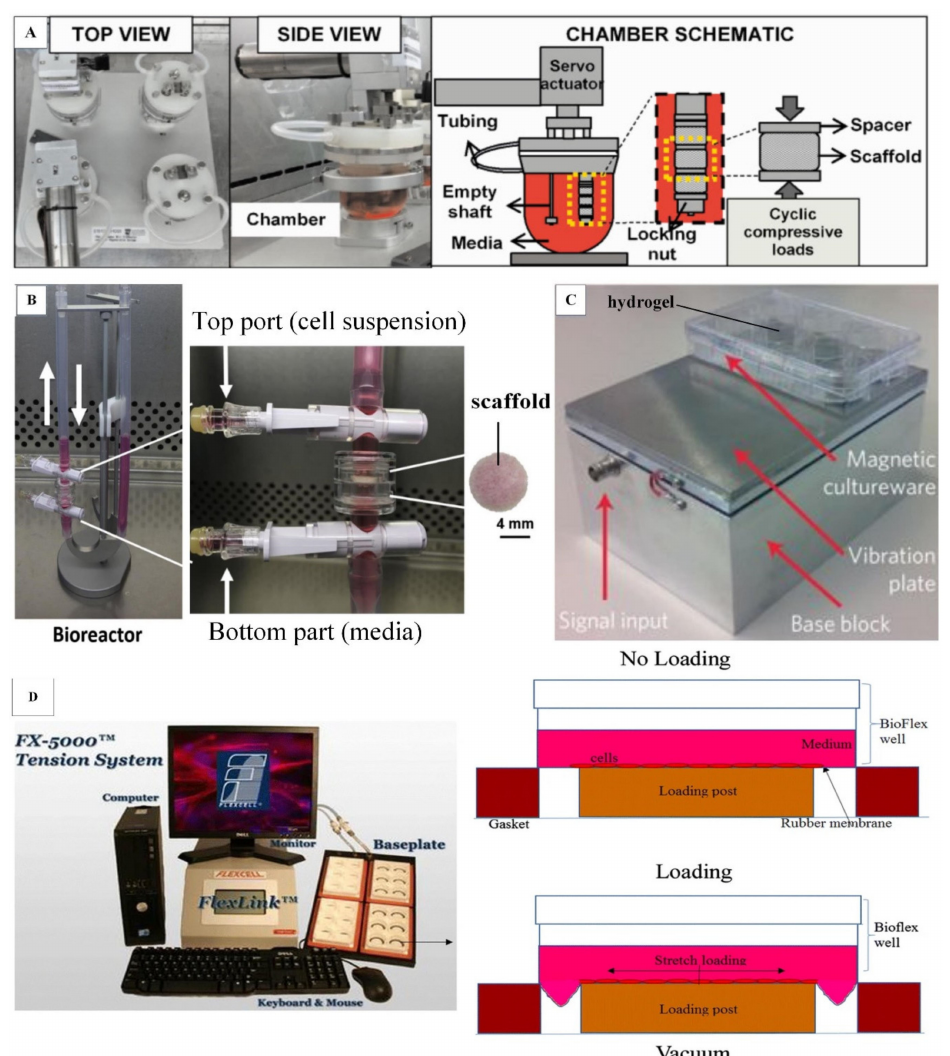
Figure 1. Bioreactors for bone tissue engineering. ( A ) Compression bioreactor. The locking nut tightens the sca ff olds to the shaft of the chamber lid and support the sca ff olds from the bottom. During loading, the locking nut and a micromanipulator on the top of the chamber compress the sca ff olds simultaneously. Adapted with permission from [26] © John Wiley & Sons (2017). ( B ) Oscillatory perfusion bioreactor. Perfusion rate is controlled by a syringe pump connected to the perfusion bioreactor. Adapted with permission from [8] © Elsevier (2017). ( C ) Vibrational bioreactor. The vibration plate has a layer of magnetic stainless steel that allows a magnetic well plate to be adhered firmly on the vibration plate. This provides extra rigidity to ensure the consistent transfer of vibration amplitude across each well. Adapted with permission from [28] © Springer Nature (2017). ( D ) Stretching device. During loading, the cells cultured on the rubber membrane are stretched when the membrane deforms downwards under the negative pressure. Adapted with permission from [62] © Creative Commons Attribution License